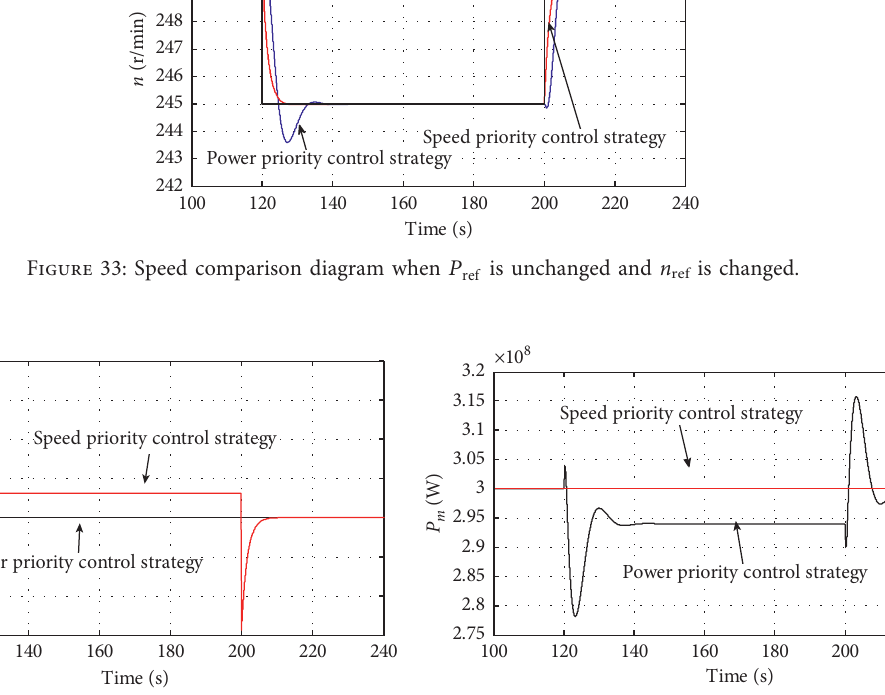
is unchanged and n ref is changed. (a) Comparison diagram of mechanical power. ref